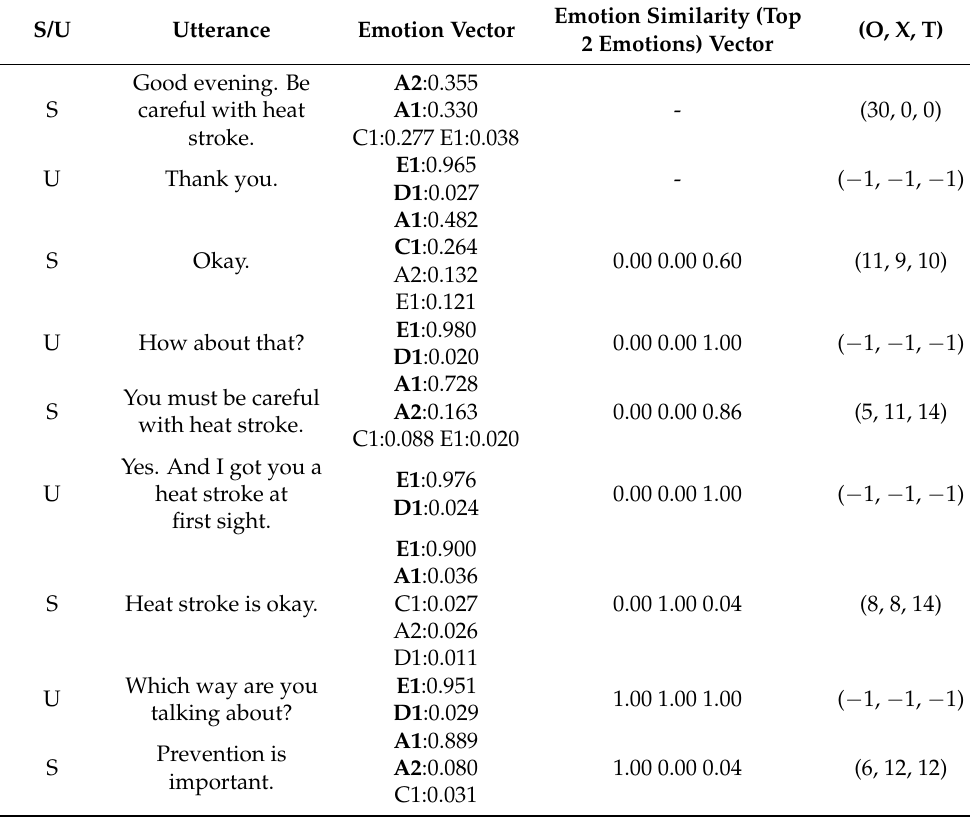
Table 7. Example of dialogue sentences and emotion similarity